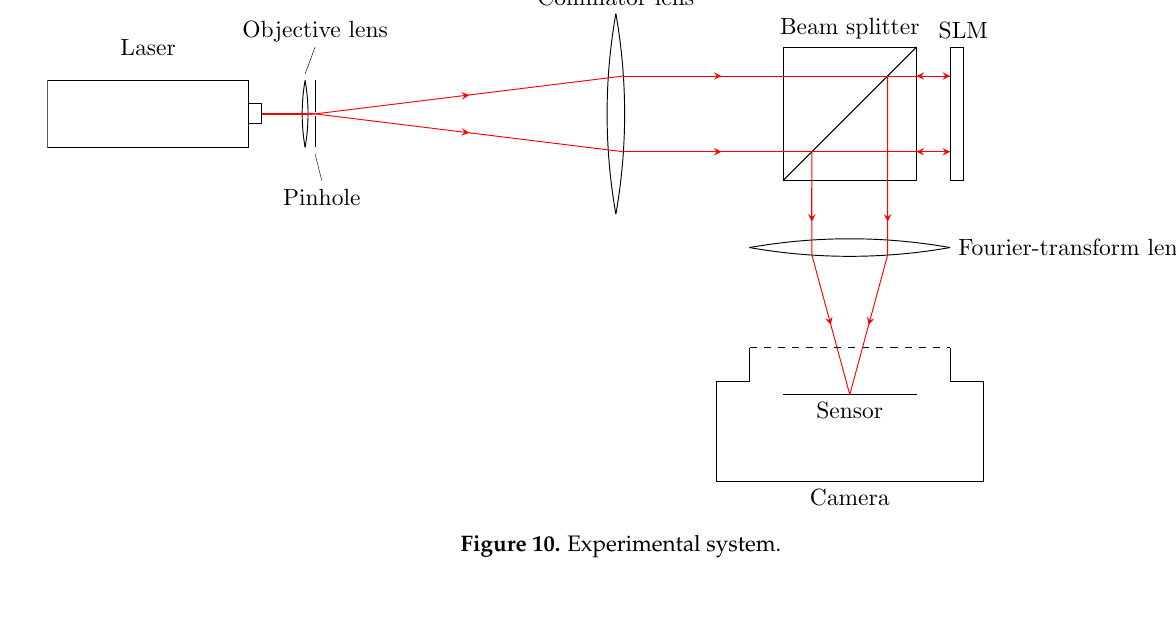
Figure 10. Experimental